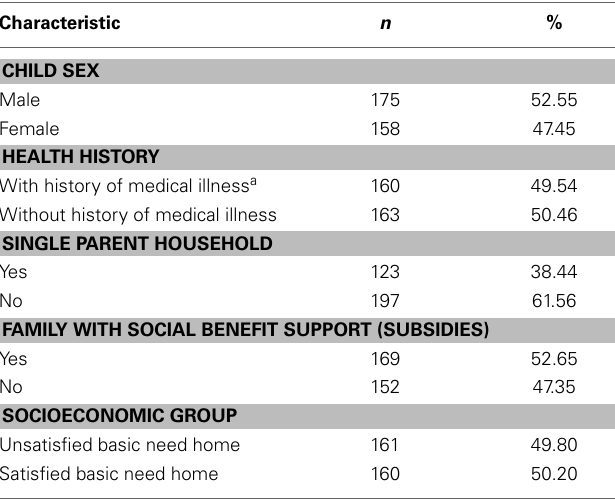
Table 10 | Socio-demographic information of the CTP sample (categorical